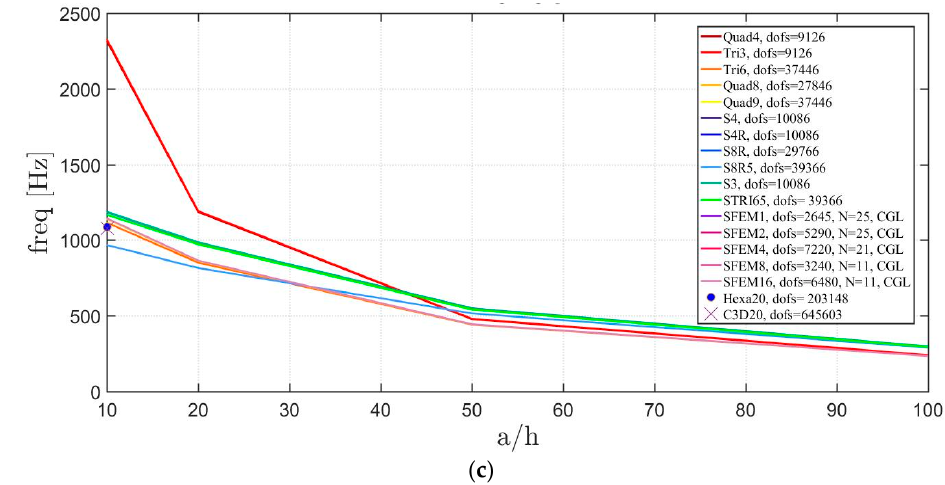
Figure 15. Thickness effect on the first three natural frequencies of a skew plate with a symmetric lamination scheme: ( a ) First frequency; ( b ) Second frequency; ( c ) Third frequency.